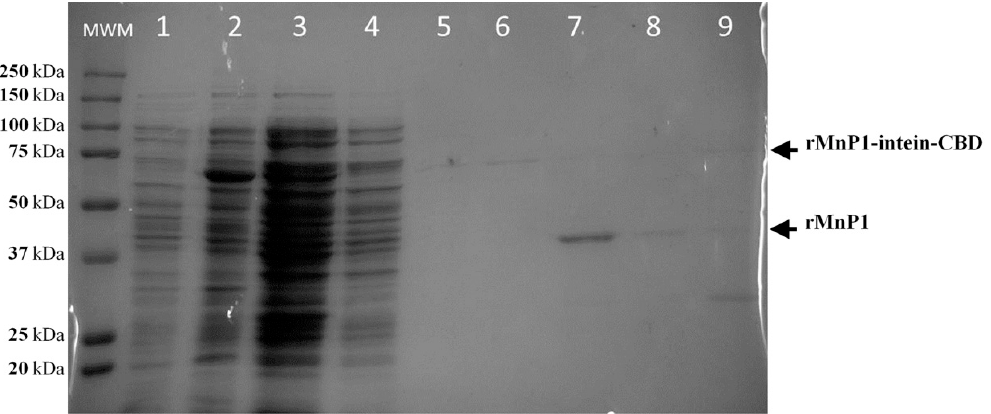
Figure 5. Purification of rMnP1. SDS–PAGE analysis for the purification of rMnP1 by one-step affinity chromatography. When cultures reached an OD 600nm of 0.5, they were induced with 0.1 mM of IPTG and incubated at 37 °C for 12 h. Inclusion bodies, containing fusion protein rMnP1-intein-CBD, were solubilised with 4 M urea. Lane 1 : Uninduced cells. Lane 2 : Induced cells. Lane 3 : Inclusion bodies treated with 4M urea. Lane 4 : Chitin column flow-through containing unretained proteins. Flow- through after washing with column buffer (Lane 5) and after treating with cleavage buffer (Lane 6) . Lanes 7 – 8 : Fractions containing rMnP1. Lane 9 : Flow-through after the elution process. MWM: Kaleidoscope Protein Standard.